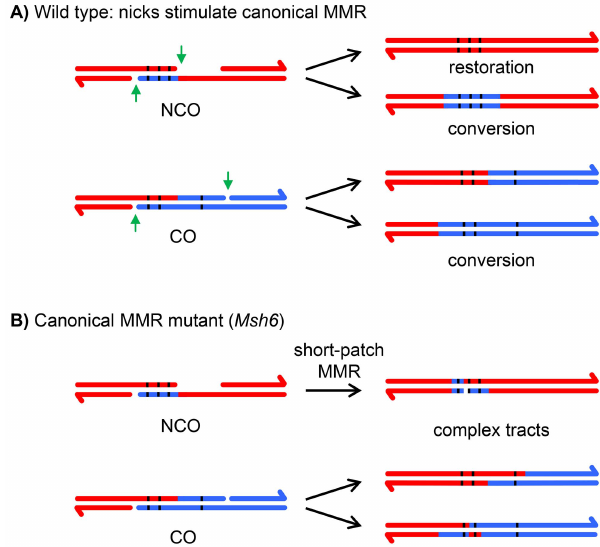
Figure 2. Effects of canonical and short-patch mismatch repair on hDNA correction. ( A ) In wild-type cells, canonical MMR is thought to be stimulated by the nicks (green arrows) left after repair synthesis is complete [11]. Any mismatches in the hDNA (black lines) can either be restored to the original genotype or converted; all mismatches within the hDNA are repaired in the same direction because canonical MMR repairs long tracts. In the case of crossovers, regions of gene conversion can only be detected by recovering both recombinant chromatids. If only one is recovered, as in most metazoan systems, regions of gene conversion are not detectable. ( B ) In a canonical MMR mutant, such as Msh6 , a short-patch MMR system is able to repair mismatches. In contrast to canonical MMR, mismatches that are very close together are repaired independently of one another (or not repaired), producing complex repair